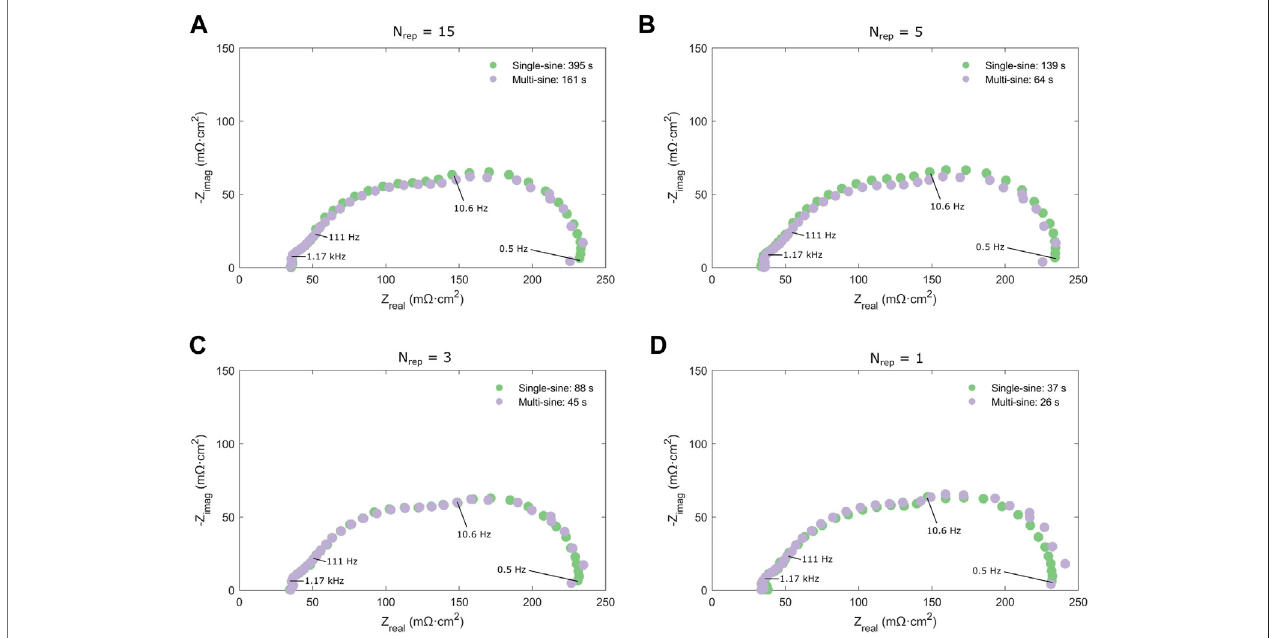
FIGURE 3 | Comparison of single-sine and multi-sine EIS with an N rep of (A) 15, (B) 5, (C) 3, and (D) 1. The total measurement time is indicated in the legends.